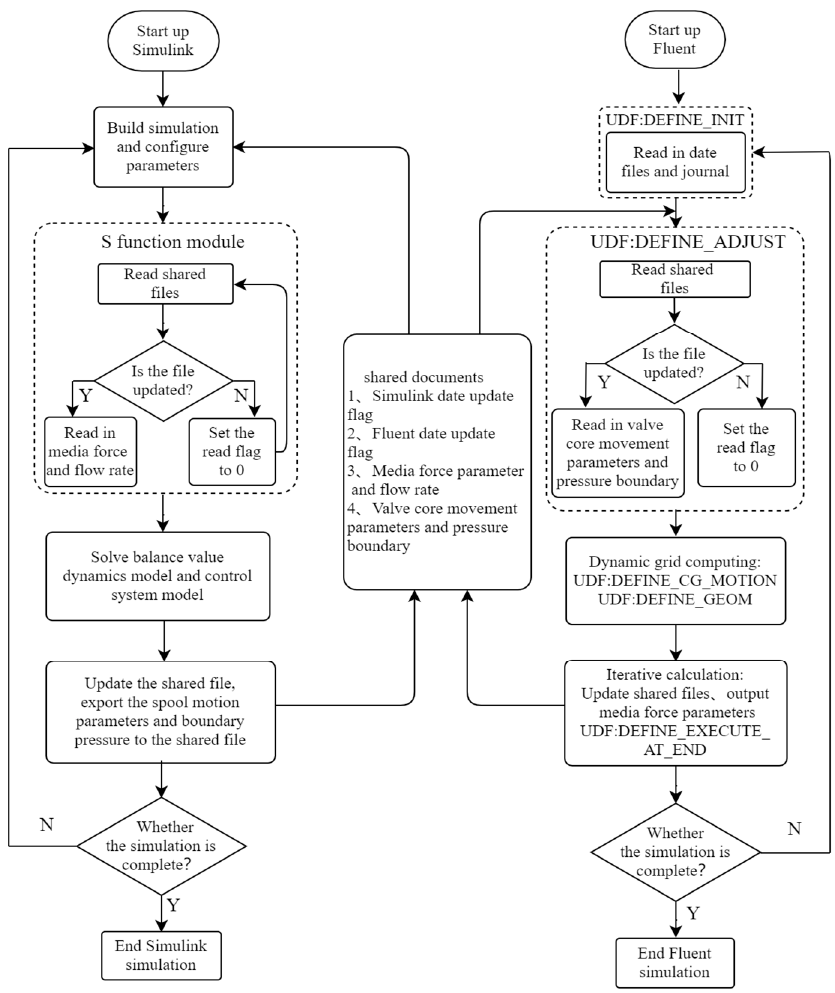
Figure 4. The principle flow chart of the co-simulation model.